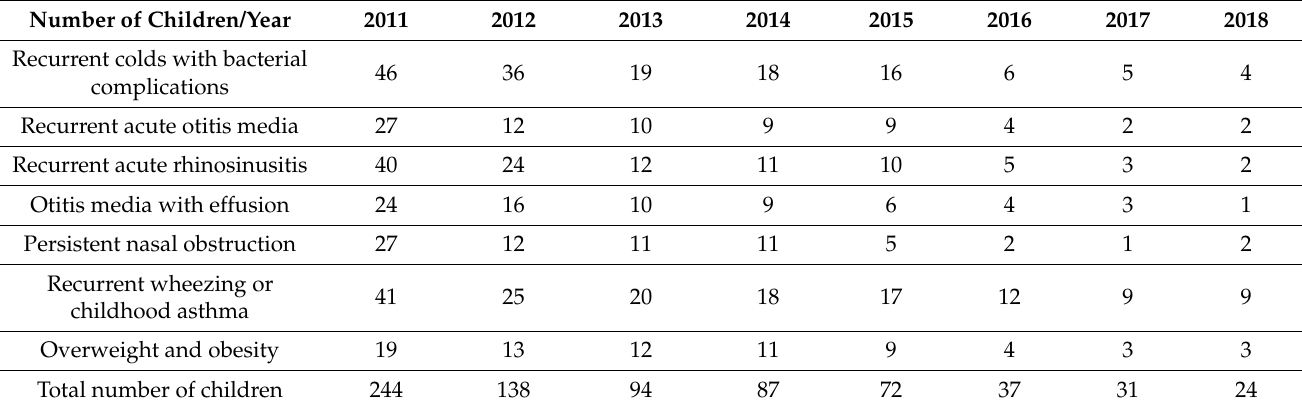
Table 2. Evolution of the annual number of patients diagnosed with IRD after the progressive introduction of the